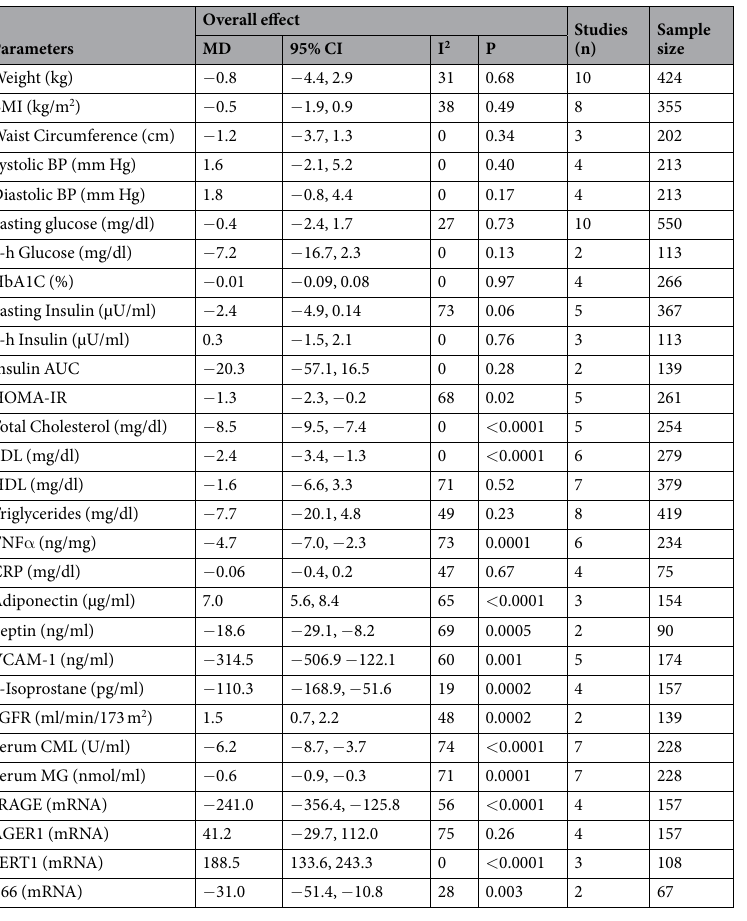
Table 1. Meta-analysis of low AGE and high AGE diets for cardiometabolic parameters. Random effects model was used. AGER1, advanced glycation endproduct receptor 1; BMI, body mass index; BP, blood pressure; CI, confidence interval; CML, carboxymethyl lysine; CRP, c-reactive protein; eGFR, estimated glomerular filtration rate; HDL, high density lipoprotein; HbA1c, haemoglobin A1c; HOMA-IR, homeostatic model of insulin resistance; Insulin AUC, insulin area under the curve; MD, mean difference; MG, methylglyoxal; P, p-value; SERT1, sertoli cell protein 1; sRAGE, soluble form of receptor for advanced glycation end